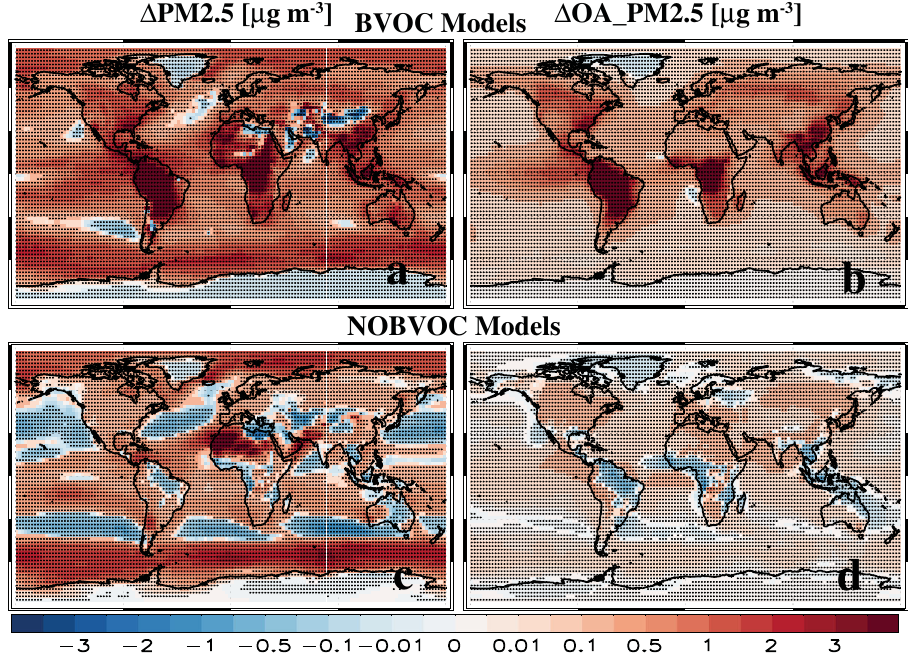
Fig. 2 PM 2.5 response to GHG-induced warming and the contribution from organic aerosol in two model subsets. Multi-model mean annual mean a PM 2.5 and b OA PM 2.5 response [ μ g m − 3 ] in fi ve models with climate-dependent BVOC emissions (BVOC models); and c , d the corresponding response in eight models that lack climate-dependent BVOC emissions (NOBVOC models). Dots represent a signi fi cant response at the 90% con fi dence level based on a two-tailed pooled t